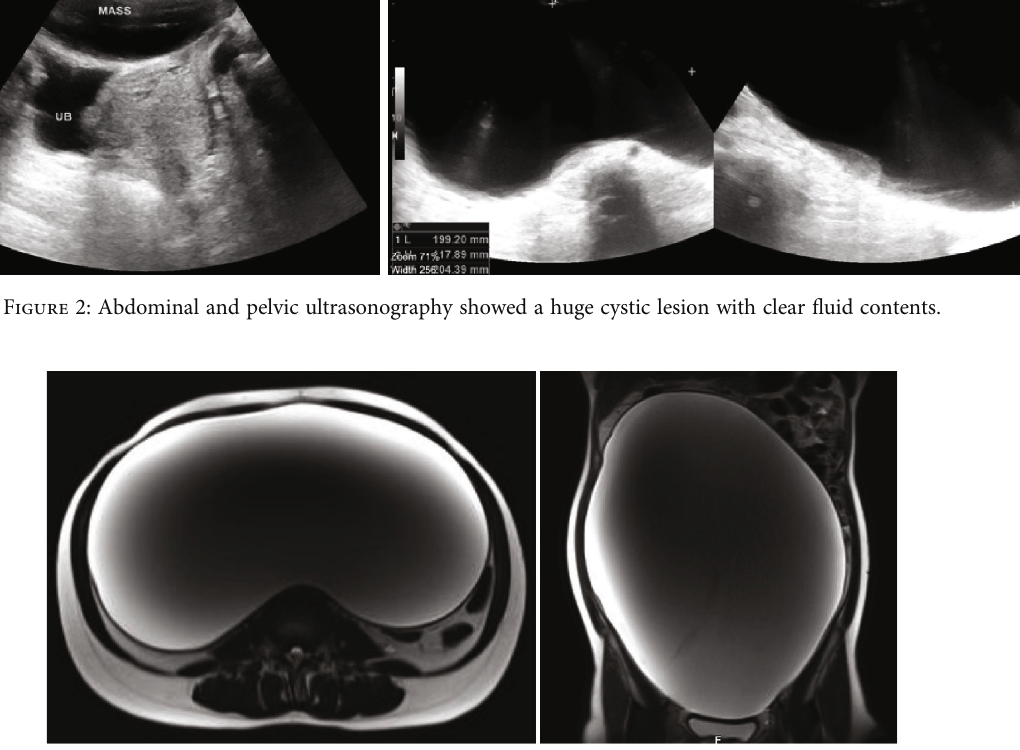
Figure 3: Pelvic magnetic resonance imaging showing a large well de fi ned pelviabdominal cystic lesion.